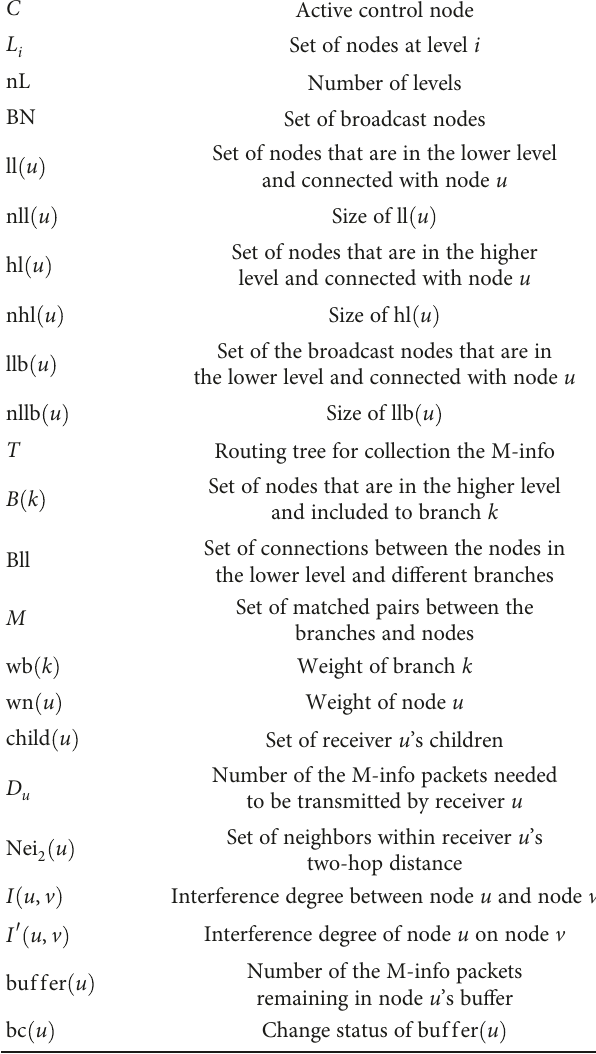
Table 1: List of notations used in the following algorithms.